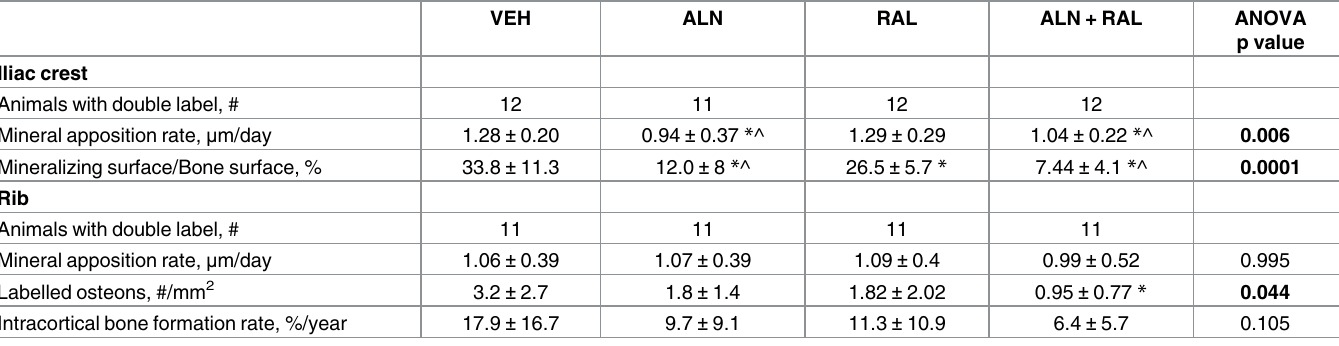
Table 2. Dynamic histomorphometry of trabecular and cortical bone.